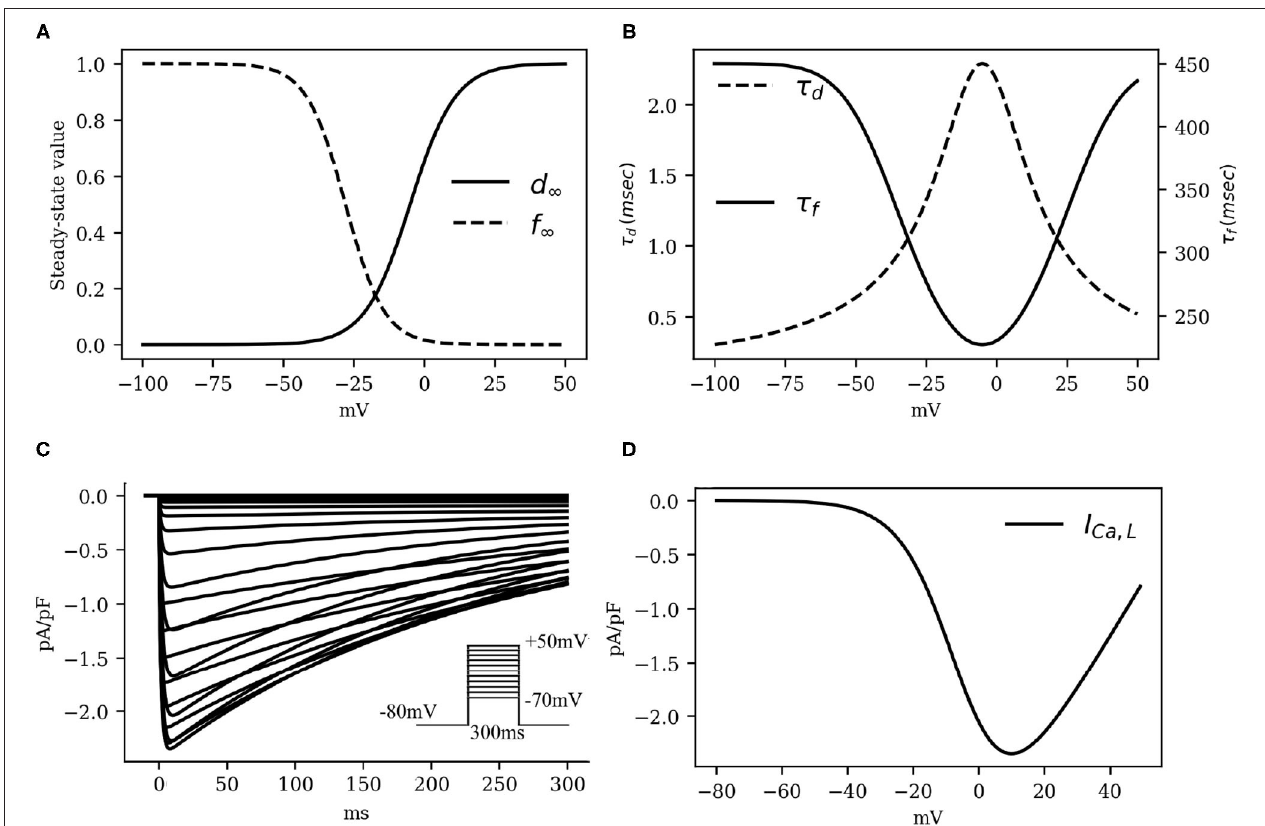
FIGURE 3 | The kinetics of the fast L-type Ca 2 + current I CaL . (A) Activation and inactivation characteristics of the steady state gating variables d and f . (B) Voltage dependence of the time constants for activation ( τ d ) and voltage-gated inactivation ( τ f ). (C) Simulated traces of I CaL (traces at 5 mV steps from minimum to maximum in the inset). Intracellular Ca 2 + concentration was kept constant at [ Ca 2 + ] i = 0.0001 mM . (D) I CaL Current-Voltage characteristics.